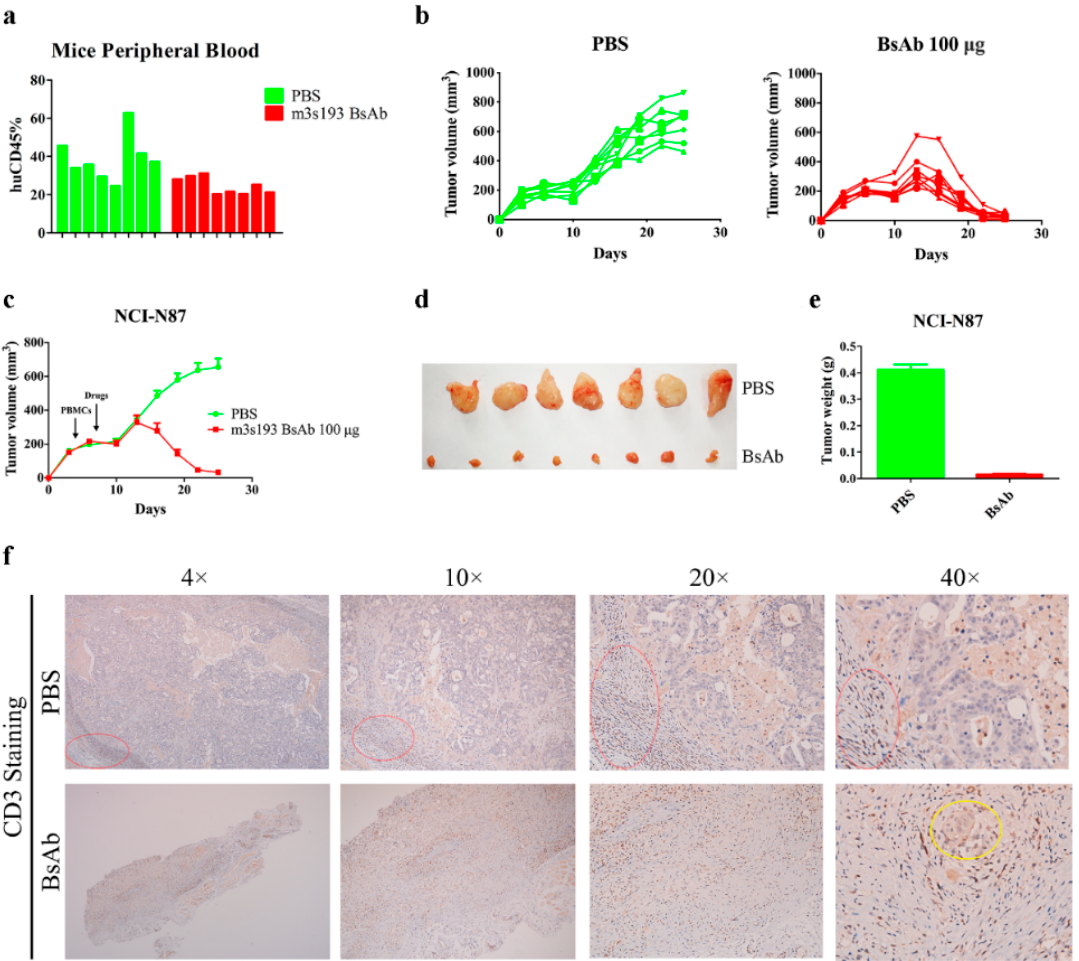
Figure 7. In vivo anti-tumor activity of m3s193 BsAb with i.v. transfer of huPBMCs. ( a ) Flow-cytometry analysis of huCD45 + cells in mice peripheral blood. ( b ) Individual tumor growth curve with time course. Data are presented as measured tumor volume from each mouse in two groups. ( c ) Mean tumor growth curve with time course. Data are presented as mean ± SD. ( d ) The digital image of stripped tumors. ( e ) Weight of stripped tumors and presented as mean ± SD. ( f ) Representative images of histologic analysis of explanted tumors stained for human CD3. Red oval circle represents infiltrated huPBMCs around tumor stroma in PBS group, and yellow oval circle represents residual tumor tissue surrounded by infiltrated huPBMCs in BsAb group.